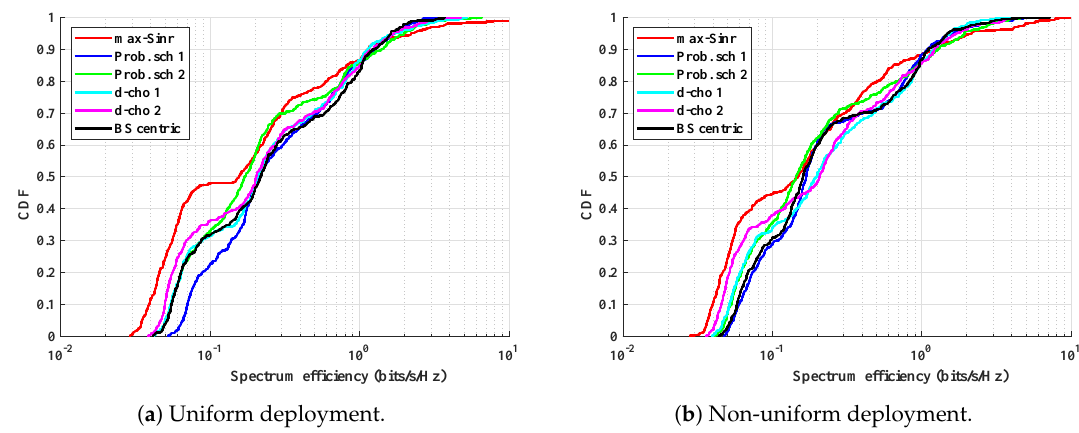
Figure 7. The cumulative distribution function (CDF) of spectrum efficiency for different association schemes in different deployment